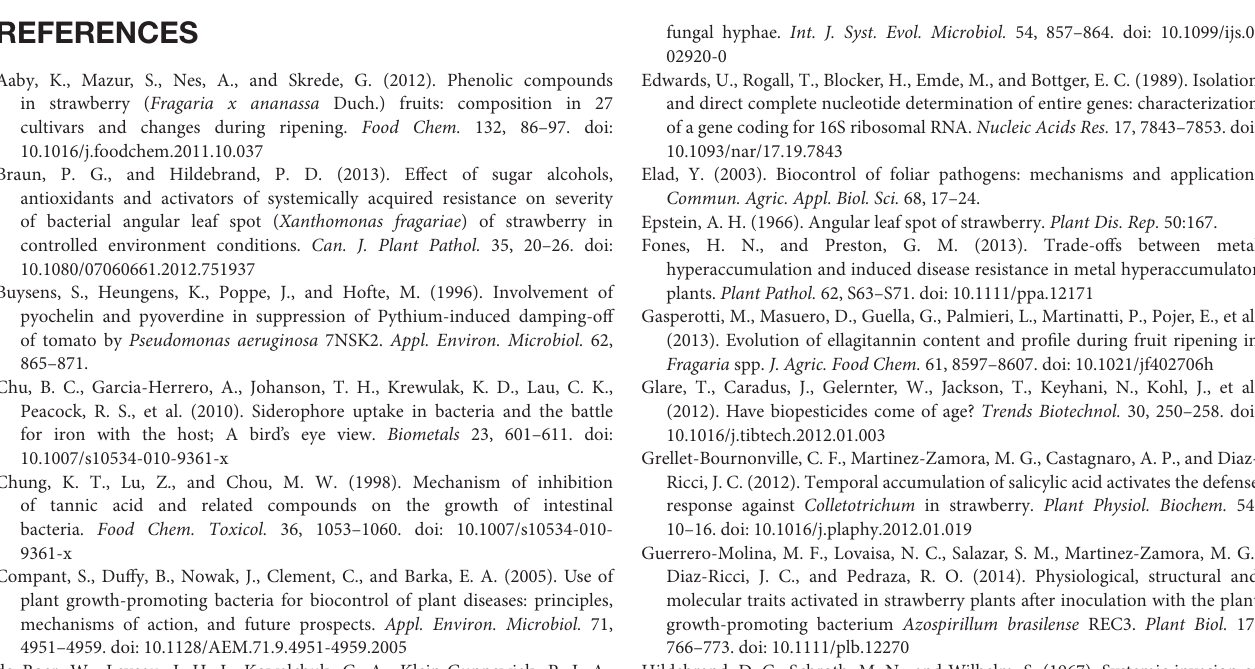
FIGURE S1 | Effect of representative strawberry isolates Fa P11 and Fa P13 on Xanthomonas fragariae growth in WBN overlays without (A) or with (B) supplemented iron (1.4 mM FeSO 4 ). Shown are composite images of plates under visible (left) or UV (right) light. Note the difference in fluorescence on WBN plates without supplemented iron between Fa P11 (not fluorescent) and Fa P13 (fluorescent), suggesting a pyoverdine siderophore produced by Fa P13 but not Fa P11. FIGURE S2 | Representative strawberry leaves that were inoculated with X. fragariae Fa P29 and (A) 0, (B) 3, (C) 100, or (D) 1400 µ M tannic acid. ALS symptoms were photographed and quantified 14 days after inoculation. See main text for